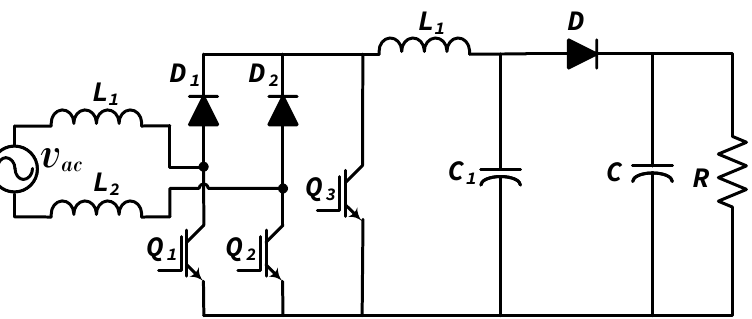
Figure 8. Semi-bridgeless boost converter with soft